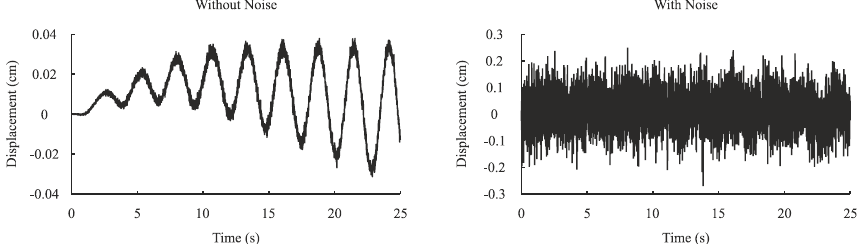
Fig. 16 The difference between the displacement signal of intact and damaged structure in the presence of noise and noise-free conditions for SD1 scenario and sensor number